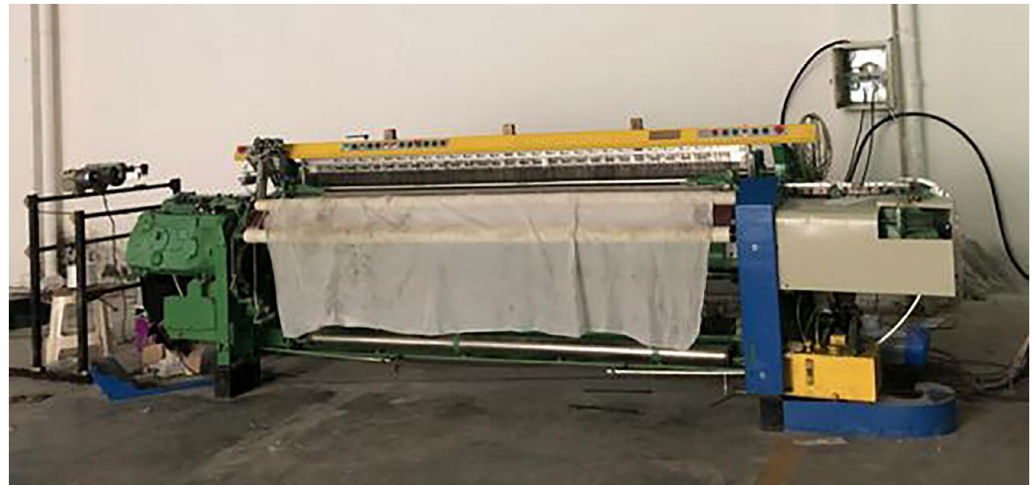
Fig 18. Debugging site of rapier